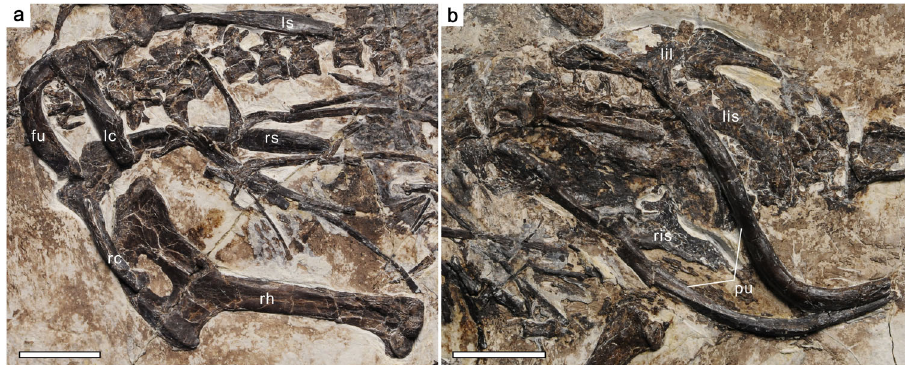
Fig. 5 Pectoral and pelvic girdles of Confuciusornis shifan holotype (PMoL-AB00178). a Pectoral girdle. b pelvic girdle. fu furcula, lc left coracoid, lil left ilium, lis left ischium, ls left scapula, pu pubis, rc right coracoid, rh right humerus, ris right ischium, rs right scapula. Scale bars: